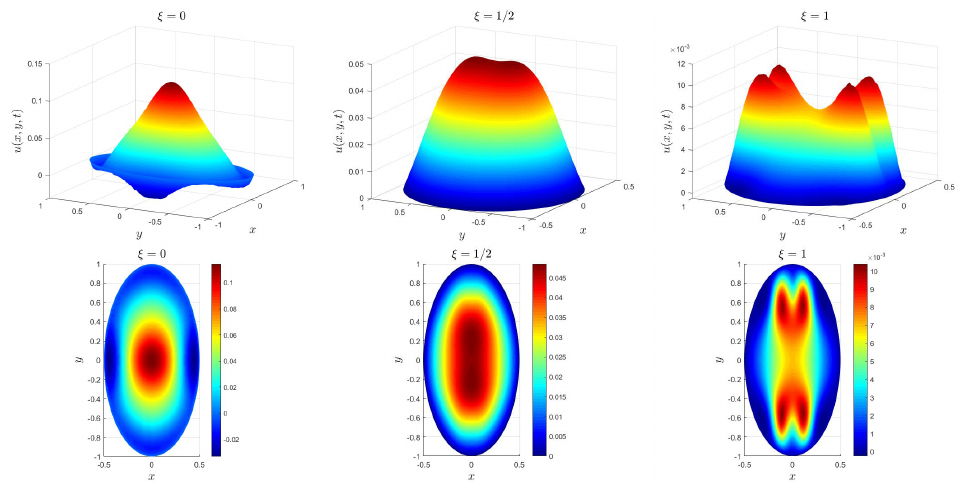
Figure 4. The three-dimensional and axial projection drawing particle distribution when ξ = 0, ξ = 1/2 and ξ =